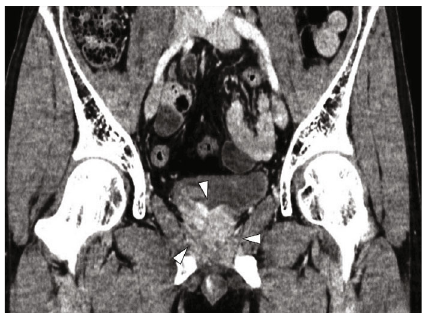
Figure 2: Prostate size was obviously reduced based on computed tomography after the administration of docetaxel